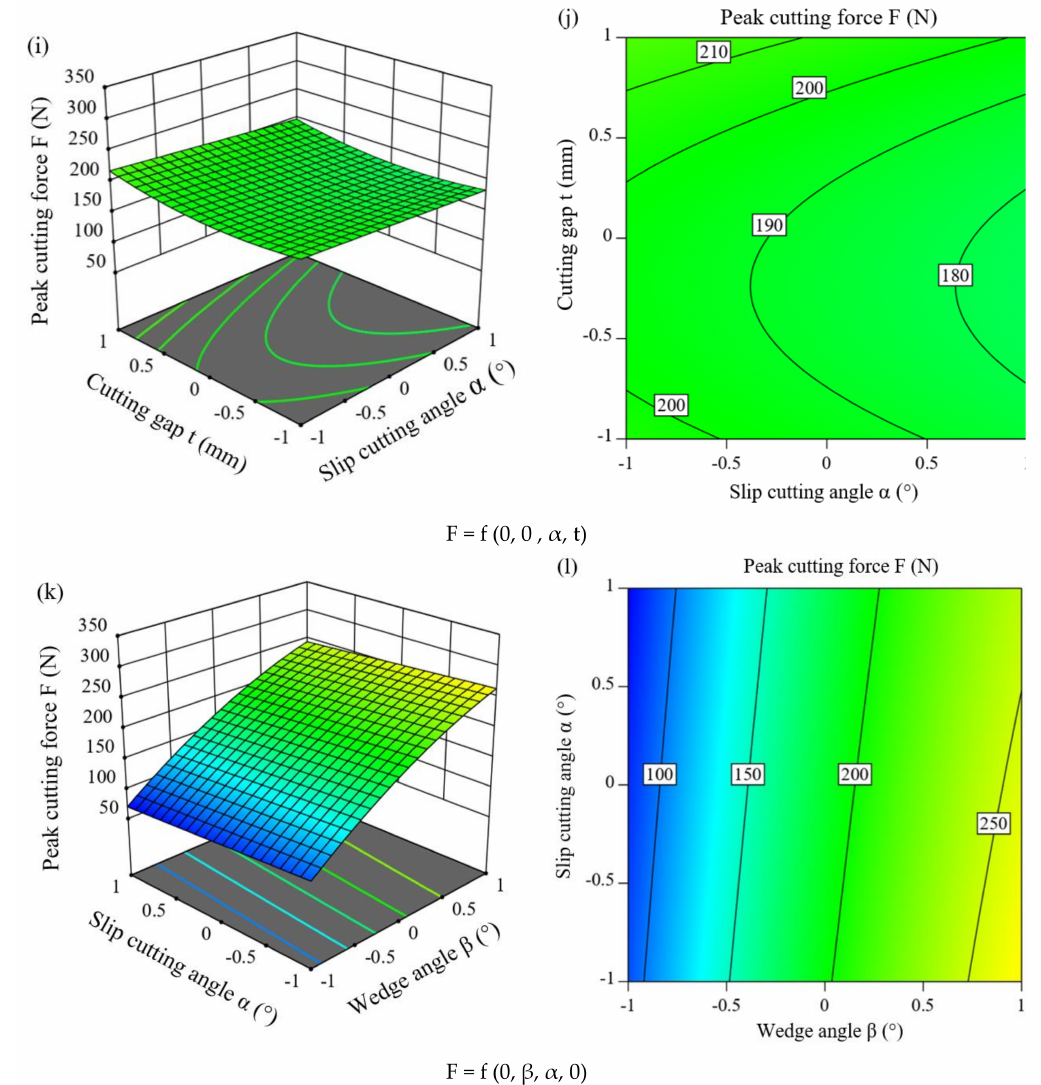
Figure 22. Response surface of interaction to peak cutting force (supported cutting). ( a ) Response surface under the interaction of Wedge angle and Average cutting speed. ( b ) Contour plot under the interaction of Wedge angle and Average cutting speed. ( c ) Response surface under the interaction of Slip cutting angle and Average cutting speed. ( d ) Contour plot under the interaction of Slip cutting angle and Average cutting speed. ( e ) Response surface under the interaction of Cutting gap and Average cutting speed. ( f ) Contour plot under the interaction of Cutting gap and Average cutting speed. ( g ) Response surface under the interaction of Cutting gap and Wedge angle. ( h ) Contour plot under the interaction of Cutting gap and Wedge angle. ( i ) Response surface under the interaction of Cutting gap and Sliding cutting angle. ( j ) Contour plot under the interaction of Cutting gap and Sliding cutting angle. ( k ) Response surface under the interaction of Slip cutting angle and Wedge angle. ( l ) Contour plot under the interaction of Slip cutting angle and Wedge